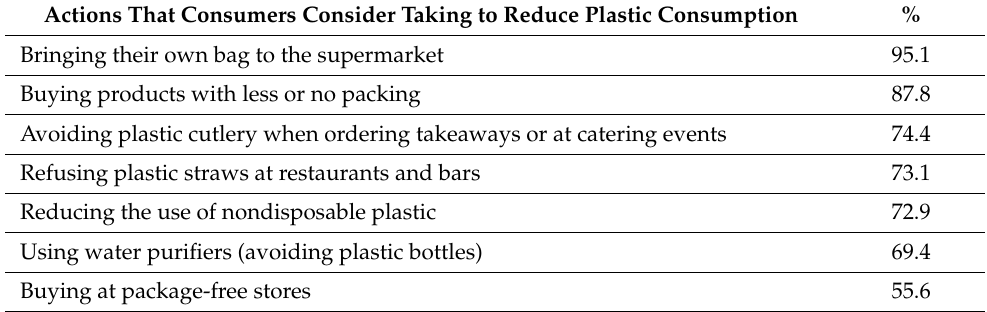
Table 1. Actions to reduce plastic consumption